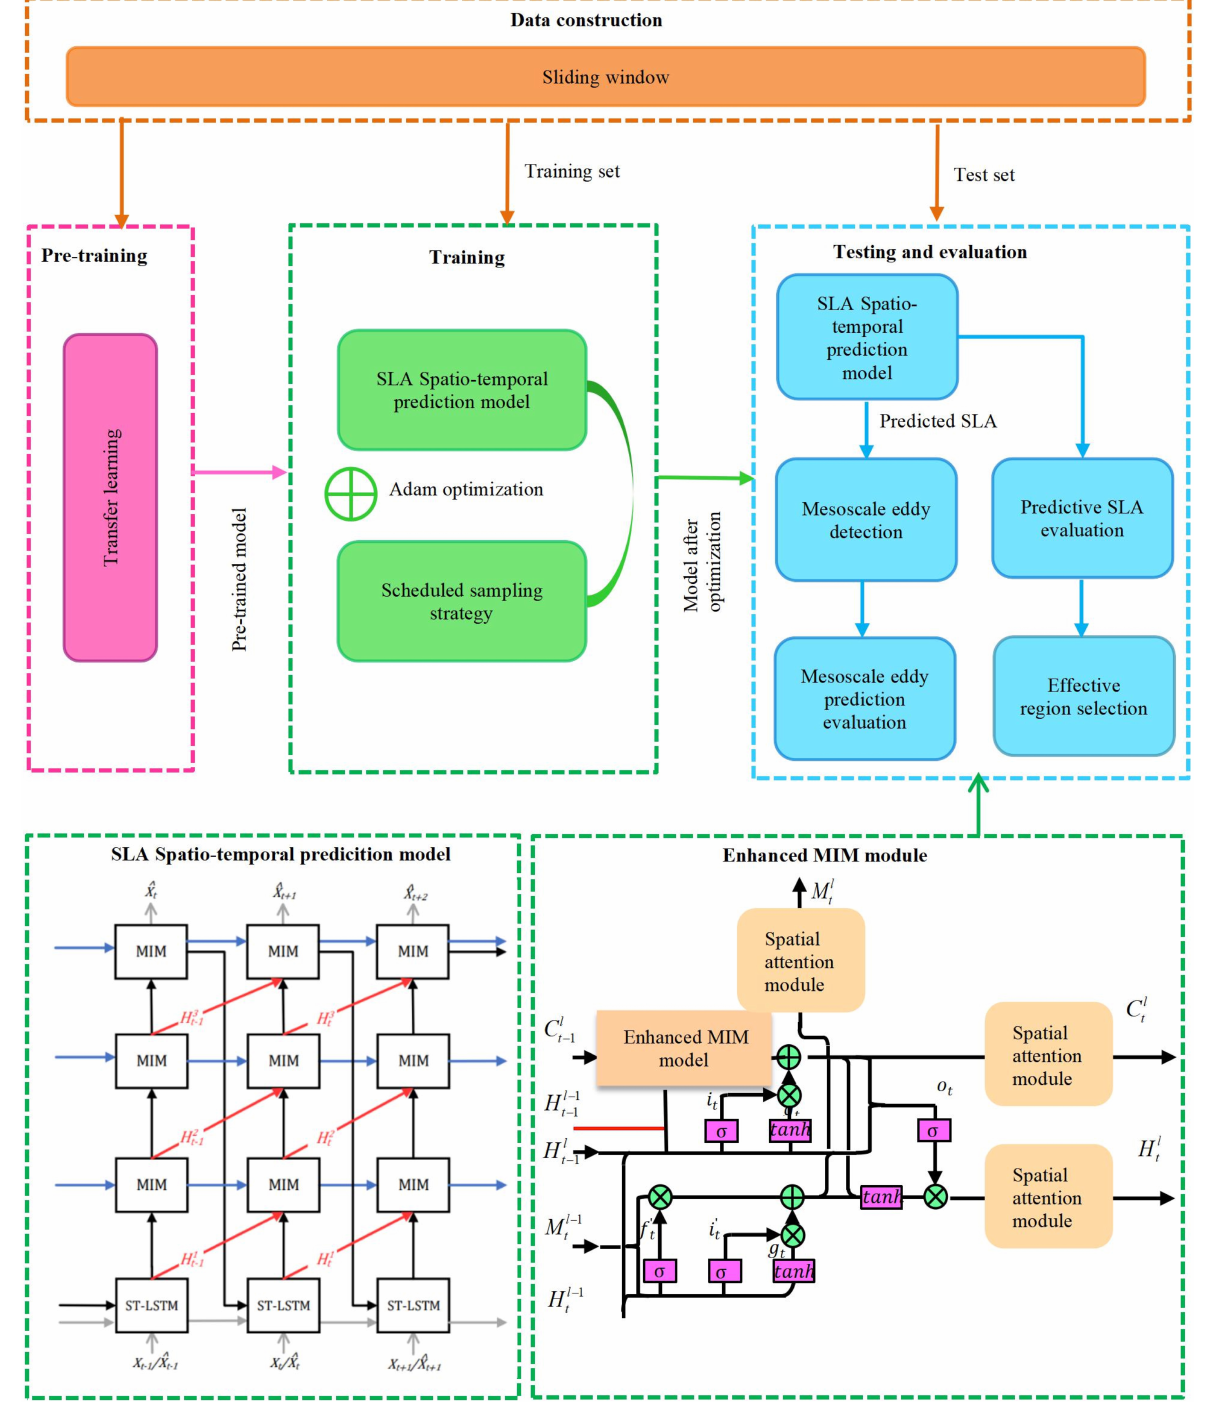
is daily. Our study area is located in the western Pacific ocean (125 ◦ − 137.5 ◦ E and 15 ◦ − 27.5 ◦ N), as is shown in Figure 2 , represented in green rectangle, where the propagation paths